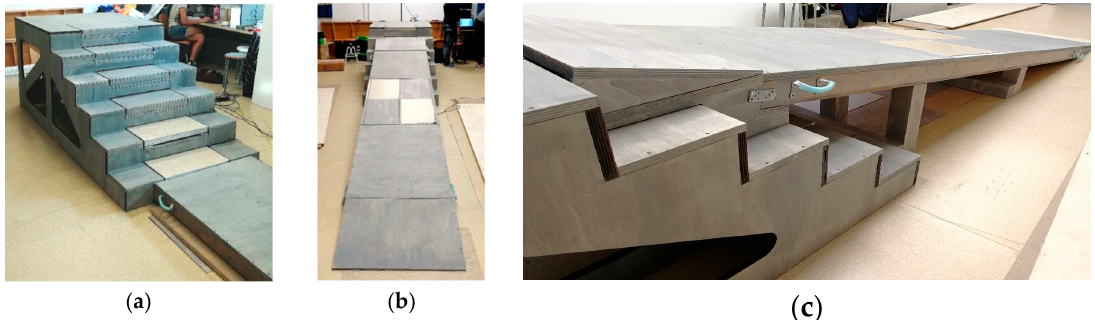
Figure 1. Instrumented stairs and ramp. ( a ) Stairs. In the photo the force platforms (beige) are located